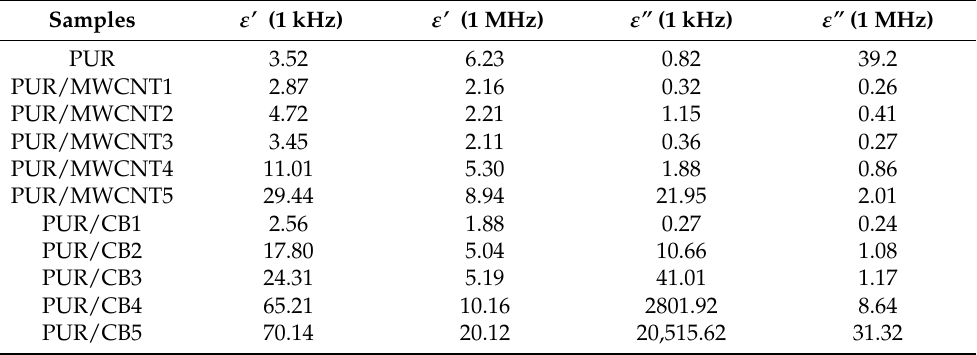
Table 3. Dielectric parameters ε (cid:48) and ε (cid:48)(cid:48) for conductive nanocomposites samples at frequencies of 1 kHz and 1